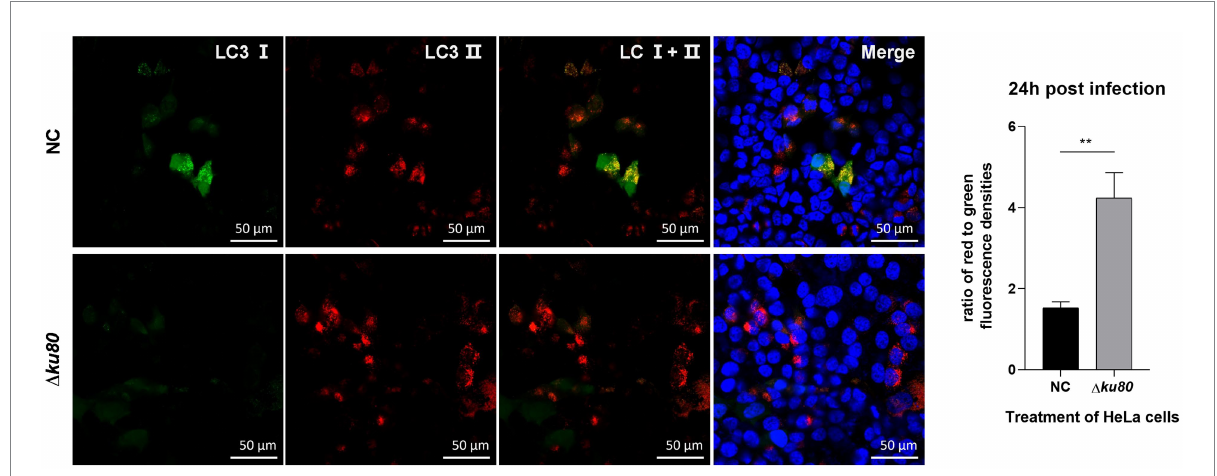
FIGURE 3 Activated autophagic flux in T. gondii infected cells. HeLa cells overexpressing mRFP-GFP-LC3 were challenged by T. gondii RH ∆ ku80 tachyzoites at an MOI of 2:1, and fixed with 4% paraformaldehyde at 24 h post-infection. Nuclei were stained with 4=,6-diamidino-2-phenylindole (DAPI). The fluorescence signals in T. gondii infected cells ( ∆ ku80 ) and uninfected cells (N) were collected in exactly the same way. Quantitative analysis of fluorescence was done using Image J. The mean density of single fluorescence over the full image range of each merged image was measured after the channels splitting, each value is the mean ± SEM of 4 microscope fields (** p ≤ 0.01; t